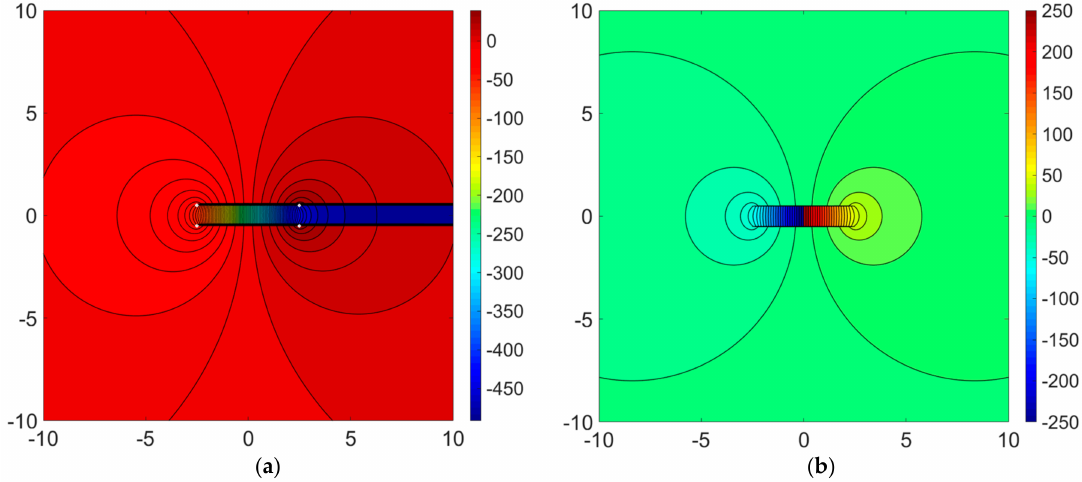
Figure 22. ( a ) Branch cuts extend horizontally exhibiting unrealistic contour for potential function. ( b ) Branch cut restricted to the center of the analytical